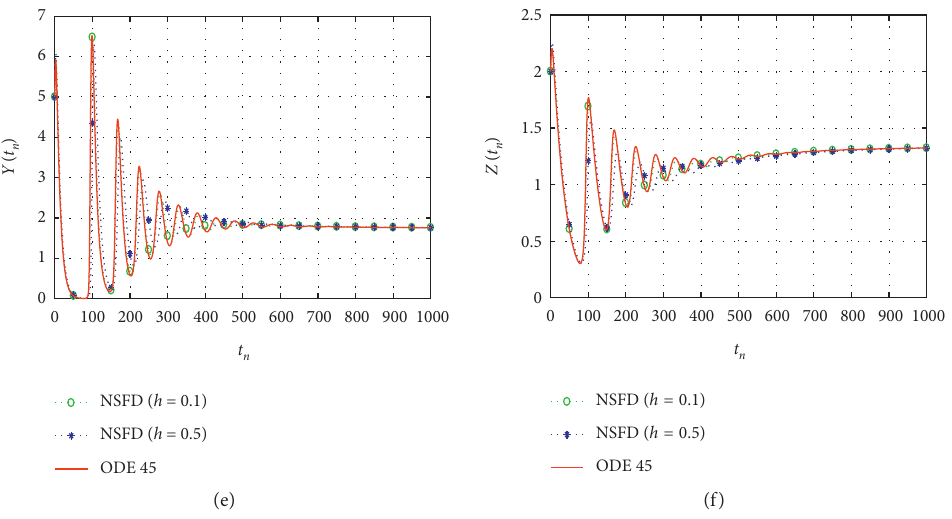
Figure 7: Comparison between the solutions of NSFD and